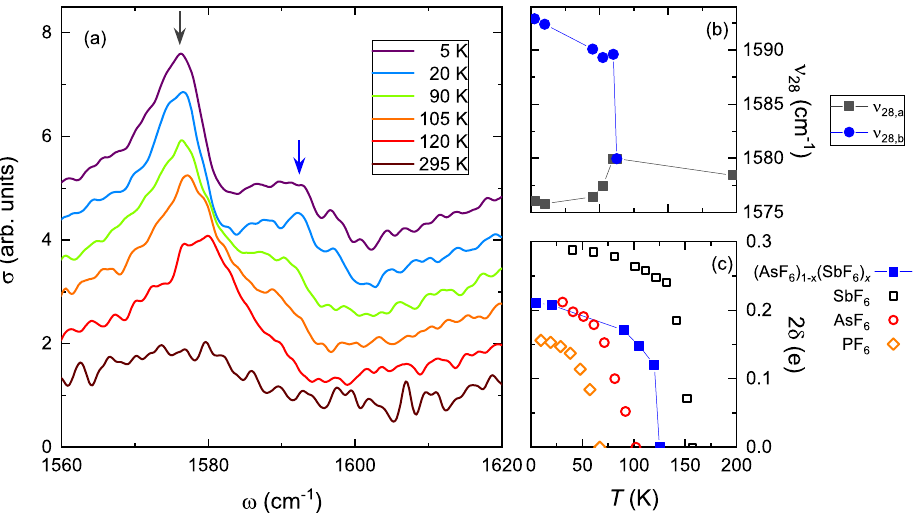
Figure 7. ( a ) Temperature dependence of the ν 28 mode in (TMTTF) 2 [AsF 6 ] 1 − x [SbF 6 ] x for x = 0.3; the spectrum is very similar to (TMTTF) 2 AsF 6 [1,12]. While the charge-rich, low-frequency peak can be identified clearly, the charge-poor, high-frequency peak is spread out more broadly. The data have been shifted vertically. ( b ) Peak frequencies from ( a ). ( c ) The charge disproportionation below T CO = 120 K approaches a similar value towards T → 0 as for (TMTTF) 2 AsF 6 . The temperature evolution of 2 δ upon CO is compared among (TMTTF) 2 X with X = PF − from